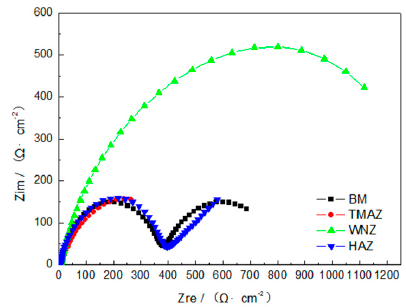
Figure 10. AC impedance spectra of different areas of the transverse section of keyhole-free FSSW joints in 3.5% NaCl solution.